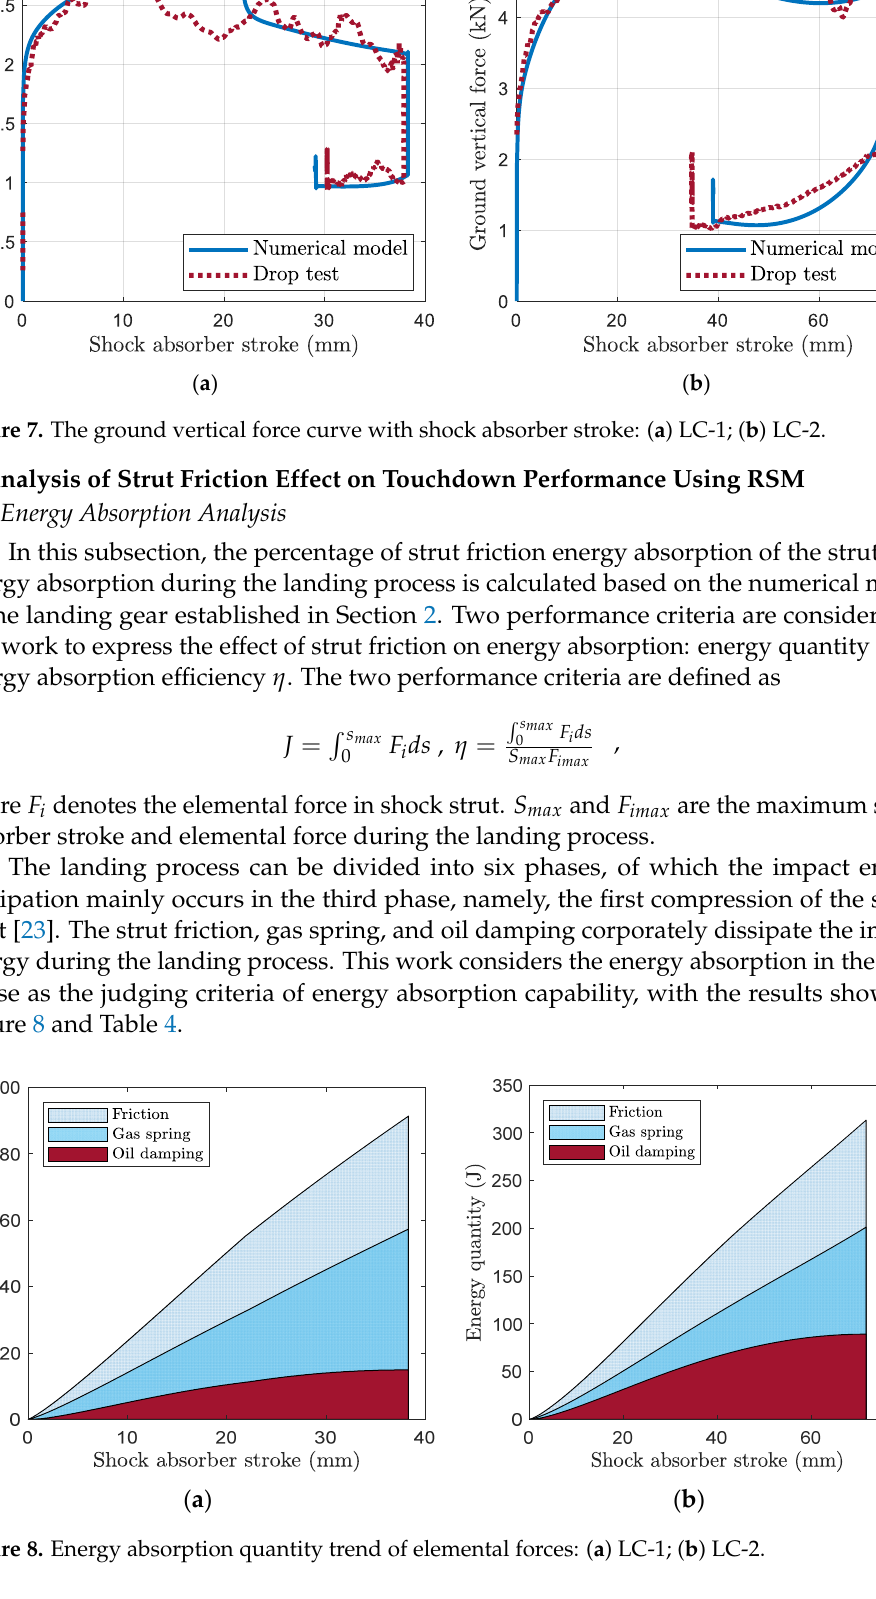
Table 4. Results of energy absorption of elemental forces. Info.